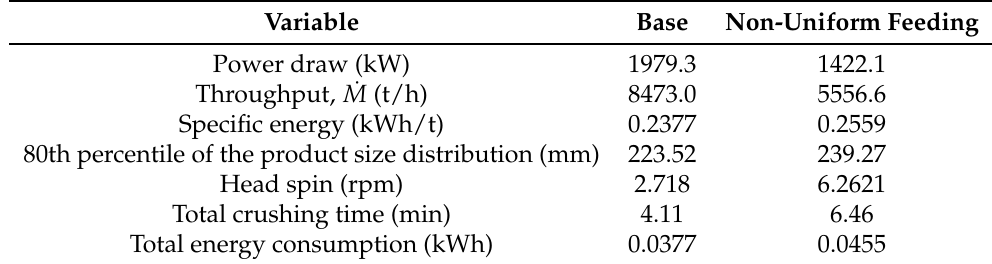
Figure 15. Comparison between base and non-uniform feeding simulations: ( a )crushing power and ( b )cumulative mass of the product. Table 8. Comparison of results between the base simulation and the non-uniform feeding